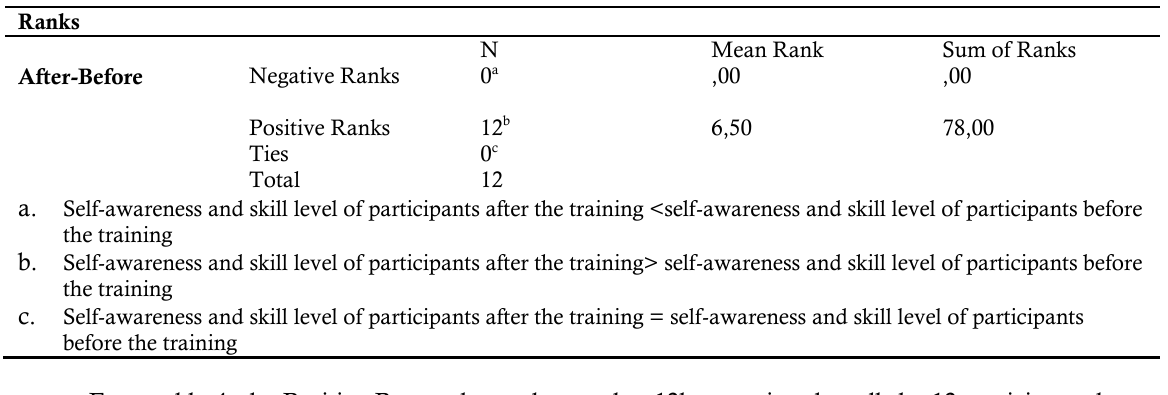
Table 4. Directions for Differences in Pretest And Posttest Competence of Education Personnel